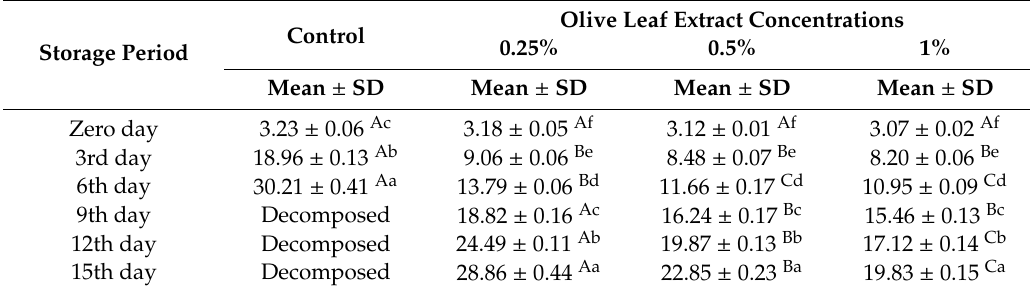
Table 3. Pattern of the total volatile nitrogen (TVN) (mg%) of the poultry meat treated with di ff erent concentrations of olive leaf extracts during the chilling storage period at 4 ± 1 ◦ C (mean ± standard deviation